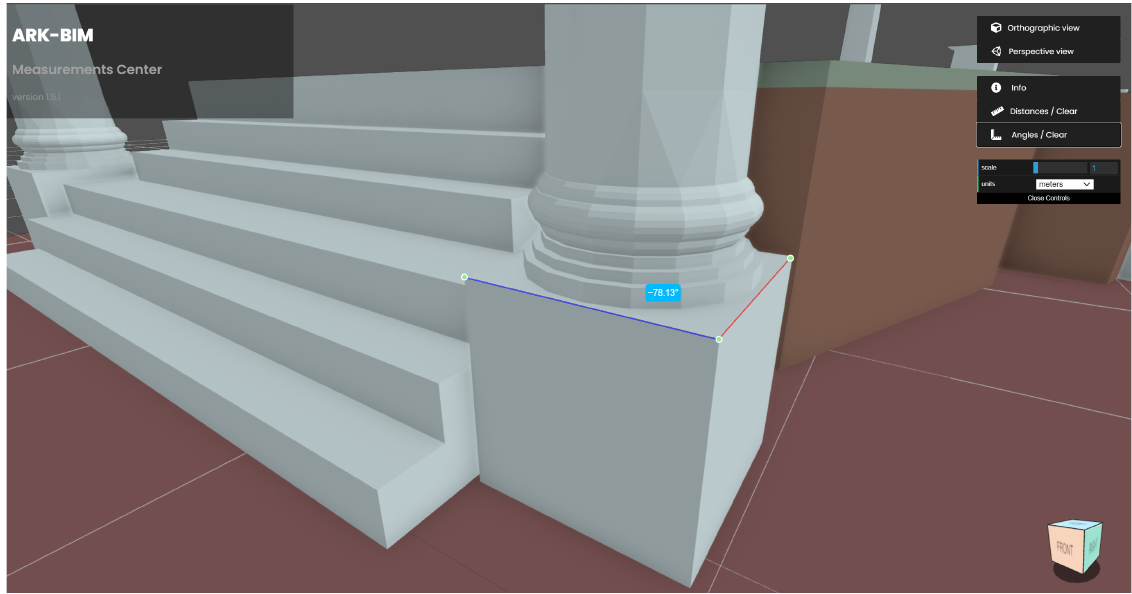
Appl. Sci. 2021 , 11 , x FOR PEER REVIEW Figure 18. ARK-BIM (version 1.5.1): Measurement Centre plugin, X-Y-Z distances on the IFC model.